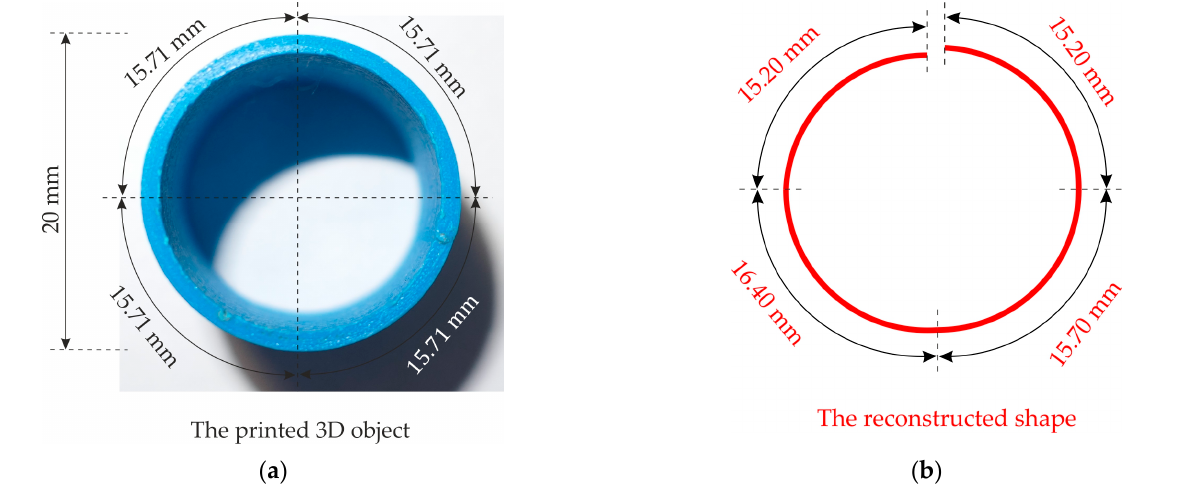
Figure 14. The reproduced object in the form of a tube: ( a ) a real shape, ( b ) reconstructed shape.